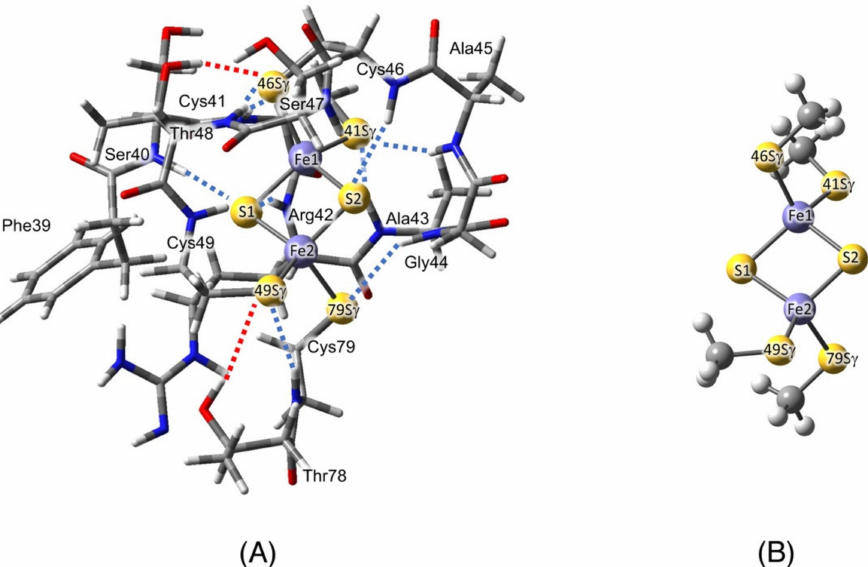
Figure 1. ( A ) Calculated model structure that consists of 13 amino acid residues involving 11 hydro- gen bonds ( 1 H ). Blue and red dashed lines indicate nine [N-H . . . S] and two [O-H . . . S] hydrogen bonds, respectively. ( B ) Cluster model of the active site where Cys41, Cys46, Cys49, and Cys79 are substituted by methanethiolate ligands ( 1 N